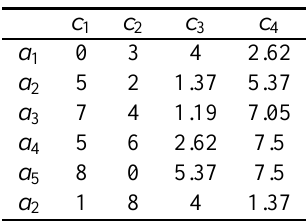
Table 3. Central values of the item